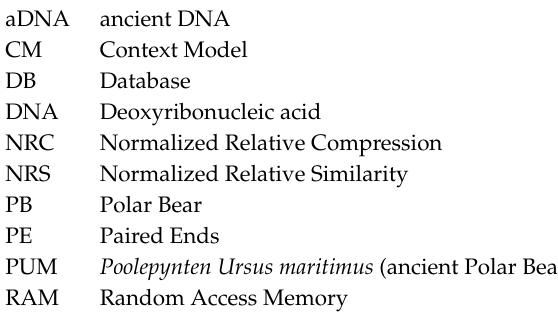
frequencies and simulated posterior predictive intervals from the fitted model are depicted at the right